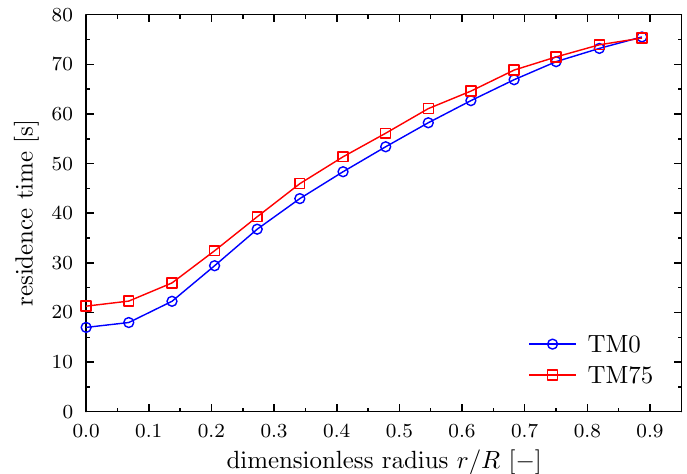
Figure 12. Dependency of the mean residence time on the dimensionless radial position (angular position corresponds to point 5). The inlet flow rate used to obtained these data in CFD simulations was 0.5 L/s.